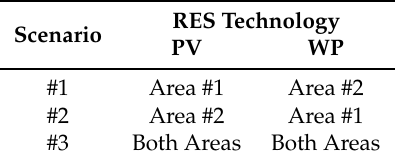
Table 7. Scenarios